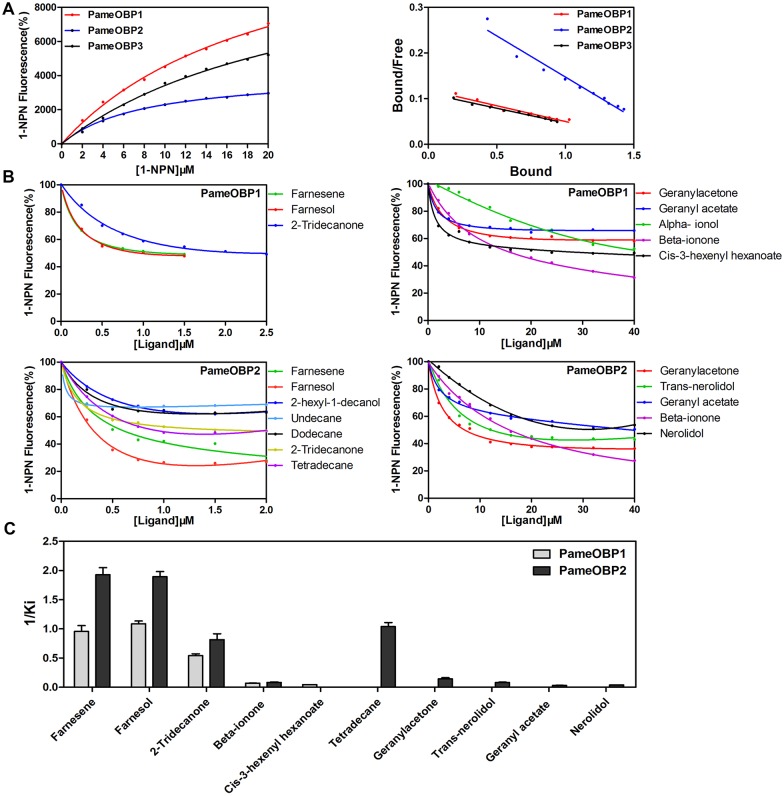
Ligand-binding assays of the PameOBPs.(A) Binding curves and Scatchard plots of PameOBPs for 1-NPN. (B) Binding curves of selected ligands. (C) Comparisons of binding affinities (indicated by 1/Ki) of PameOBPs with tested volatiles.